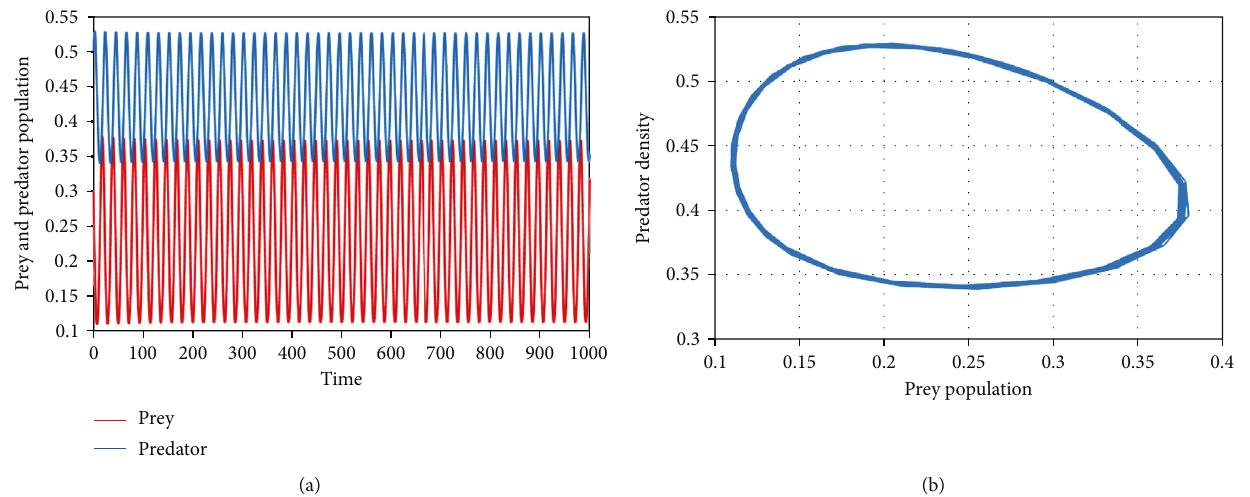
Figure 8: (a) Time series solution and (b) parametric plot of system (4) about the equilibrium point E respectively, except c 2 = 0 : 05, c 1 = 0 : 12, α = 2, and β = 0 : 2